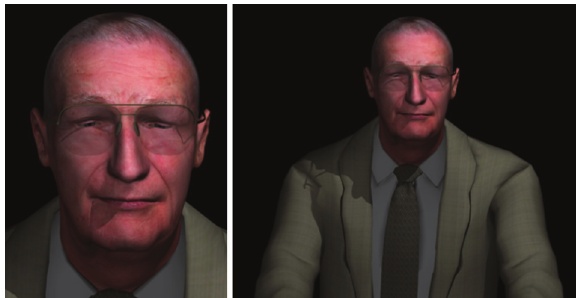
Figure 22. Result of Real-Time Soft-Edged Shadow